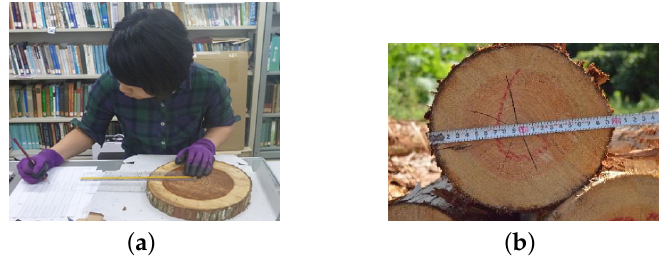
Figure 7. The features of wood were obtained by an expert. ( a ) The features of wood were obtained by an expert in indoor environment. ( b ) The features of wood were obtained by an expert in outdoor environment.